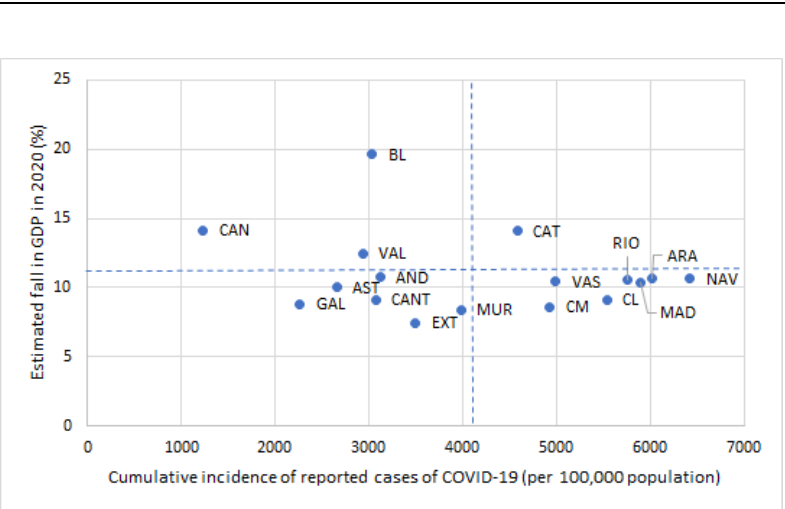
Figure 5. Gross domestic product decrease and COVID-19 incidence by Autonomous Communities. Spain 2020. Source: Own preparation based on Spanish Ministry of Health statistics and our estimates in Table 1.